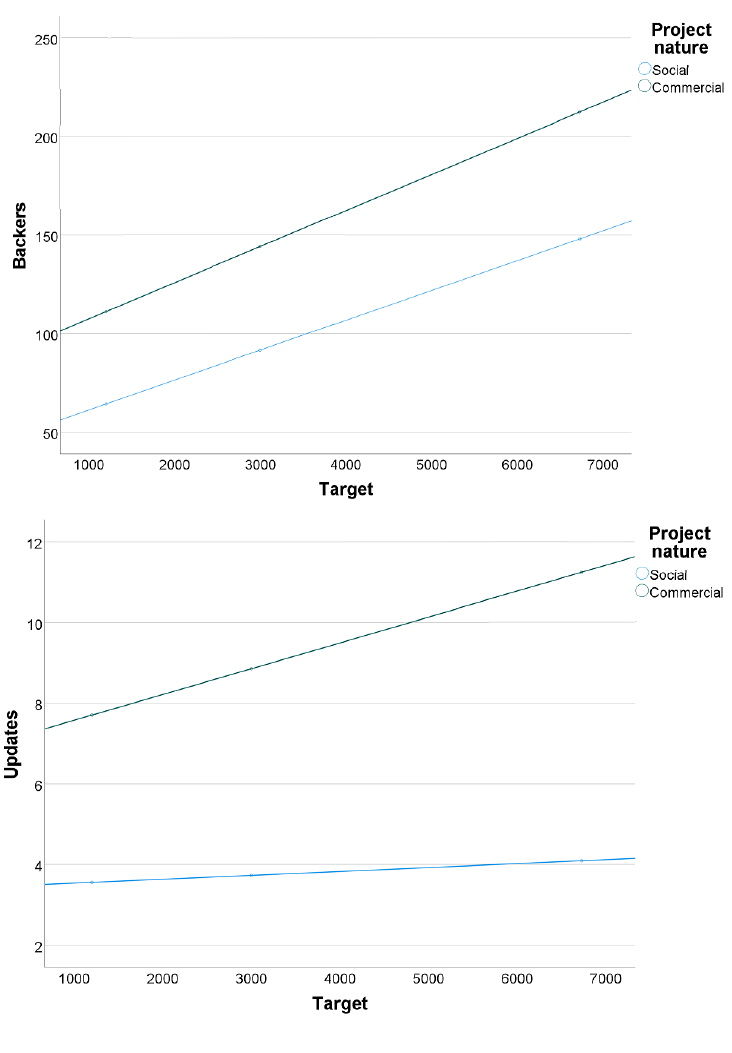
Figure 3. Relationships of Target-Backers and Target-Updates by project type.